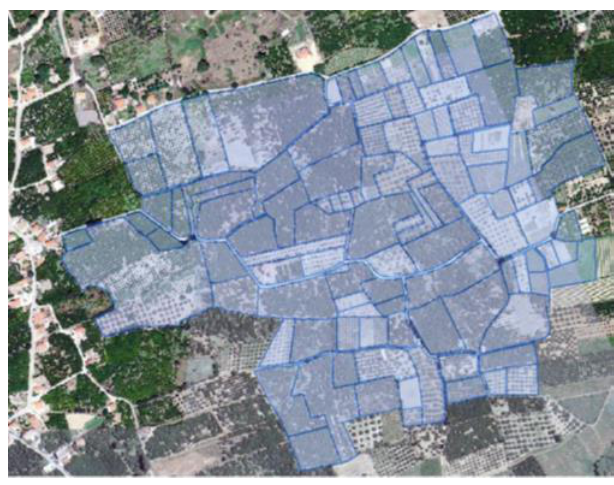
Figure 7. Digitized polygons in Gounaris village using the proposed procedure.